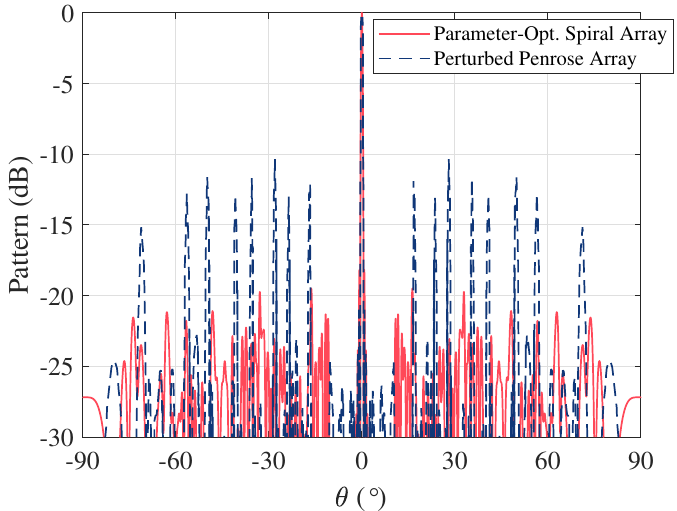
Figure 5. Array factor cuts where the peak sidelobes are located. The dashed line indicates the ϕ = 90 ◦ array factor cut of the perturbed Penrose array in Figure 4a, and the solid line indicates the ϕ = 95 ◦ array factor cut of the parameter − optimized spiral array in Figure